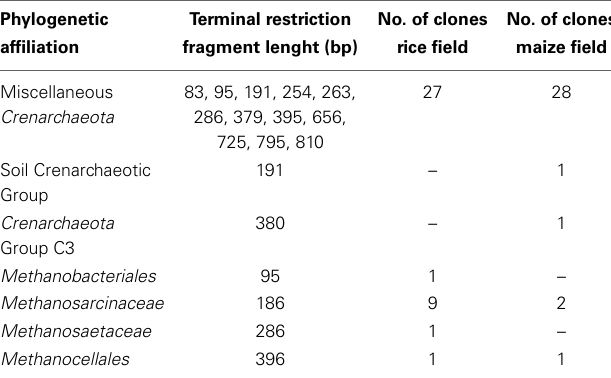
Table 1 | Lengths of distinct terminal restriction fragments (T-RFs) of different archaeal 16S rDNA clones obtained rice and maize cultivated Philippine rice field soil and affiliation with a distinct phylogenetic lineage by 16S rDNA sequence analysis of the